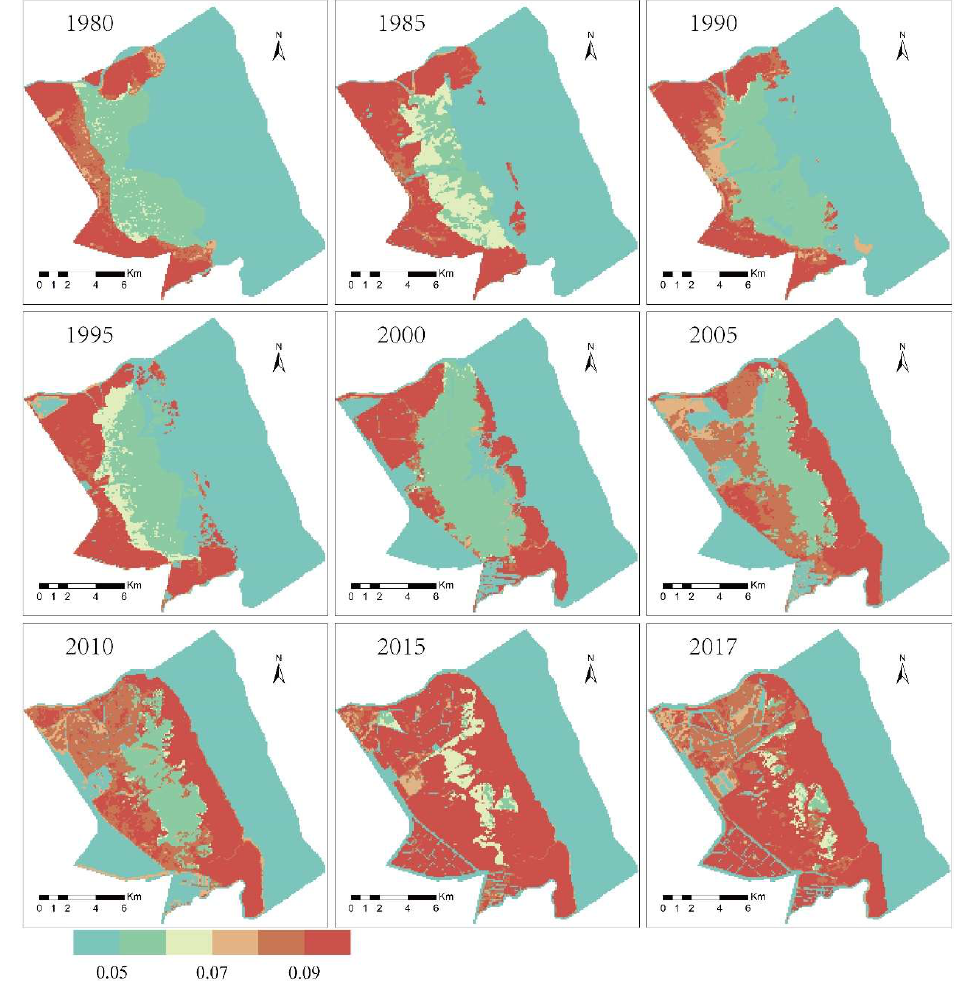
Figure 8. Distribution of Manning’s coefficient in the Yancheng coastal wetland.